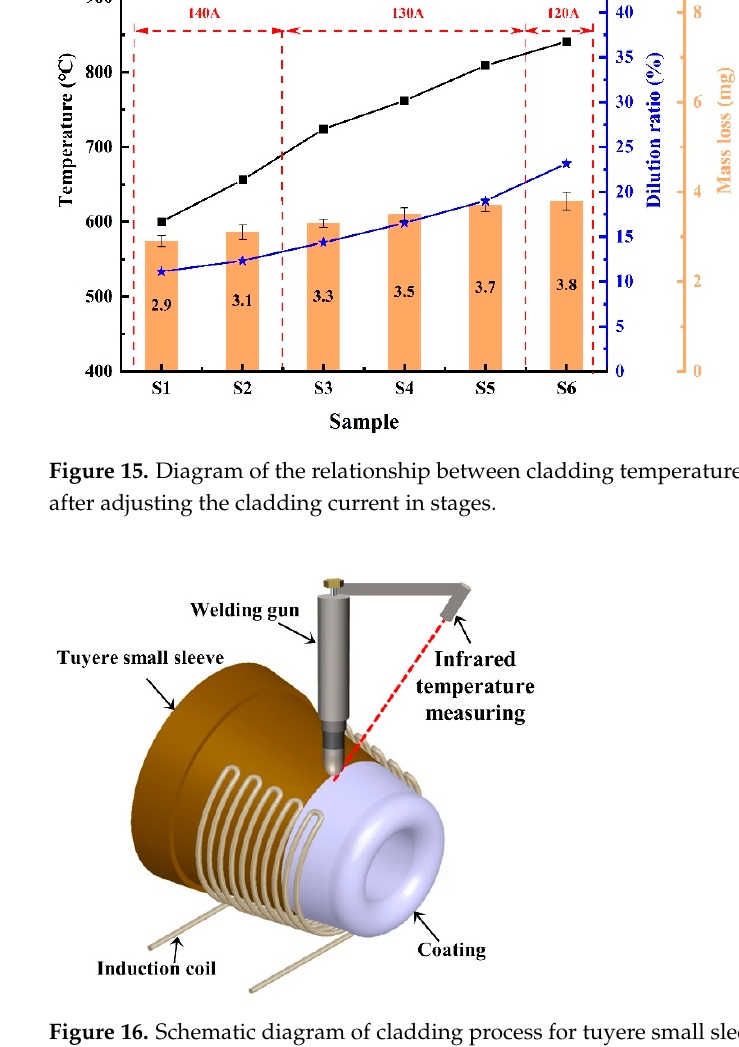
Figure 16. Schematic diagram of cladding process for tuyere small sleeve.